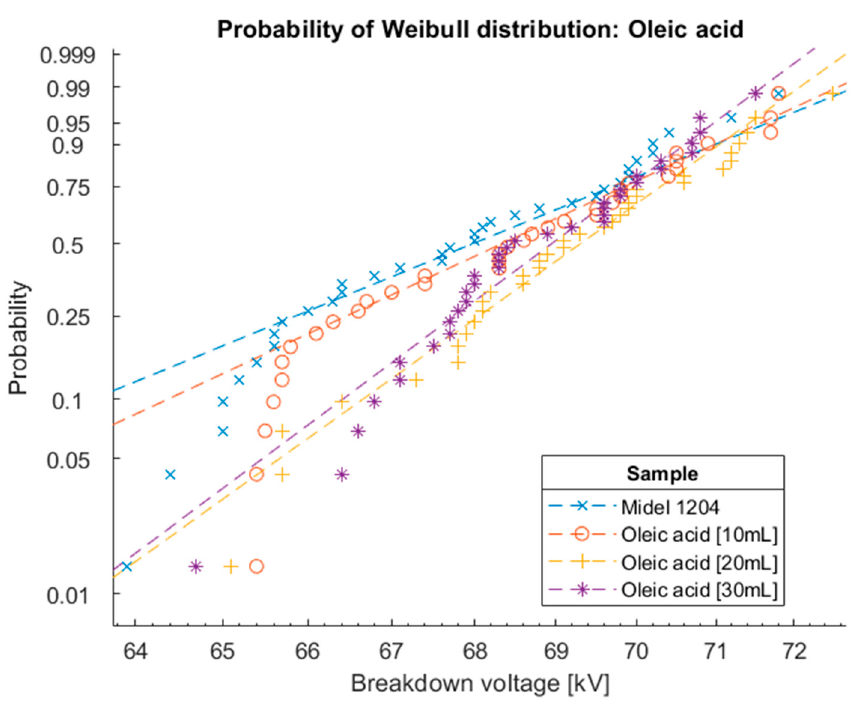
Figure 17. Cumulation distribution functions for Weibull distribution of oil Midel 1204 with different concentrations of surfactant oleic acid.